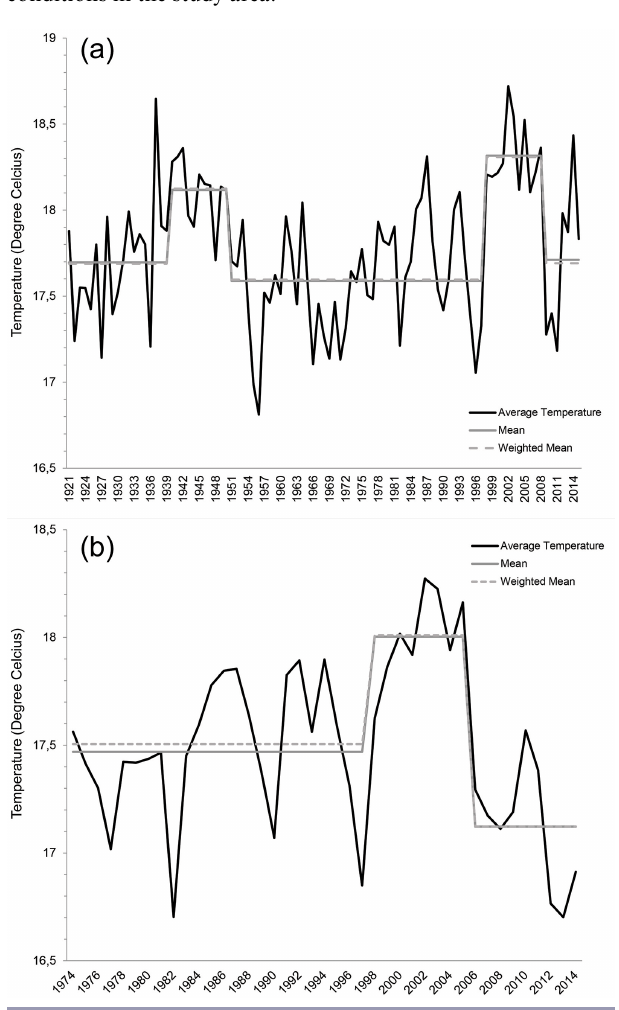
Fig. 4 . Average annual temperature (running from June to May) with regime shifts for (a) Mossel Bay, representative of coastal conditions, and (b) Riversdale, representative of inland conditions in the study area.